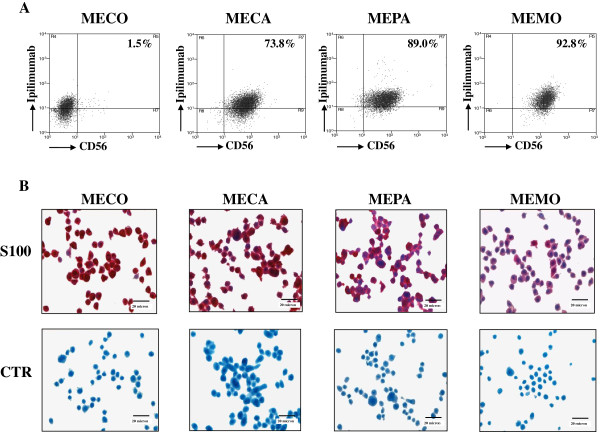
Analysis of CD56 and S100 expression in CTLA-4 positive melanoma cell lines. Panel A, cytofluorimetric analysis of direct and indirect immunofluorescent co-stainings performed with a PE-conjugated anti-CD56 (NCAM) and Ipilimumab Abs, as shown for representative cell lines. Numbers within the quadrants represent the percentage of Ipilimumab/CD56 double positive melanoma cells. Panel B, immunohistochemical staining with anti-S100 mAb and with anti-CD20 mAb used as isotype-matched irrelevant antibody providing the negative control (CTR), as shown for representative cell lines. Images were taken using magnification 400×. Scale bar, 20 micron.